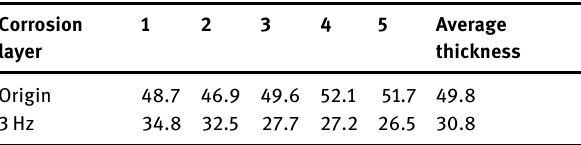
Table 3: The thickness of the corrosion layer in brass alloy with